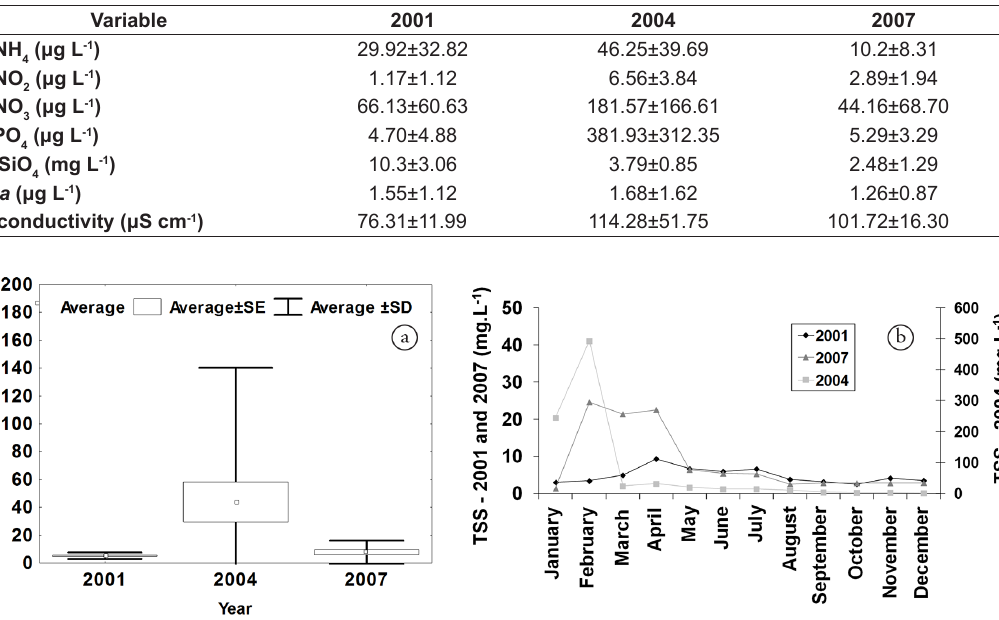
Figure 5. Inter-annual variability on the means and standard-deviations (a) and on the monthly variation (b) of TSS (total suspended sediment) during the three hydrological